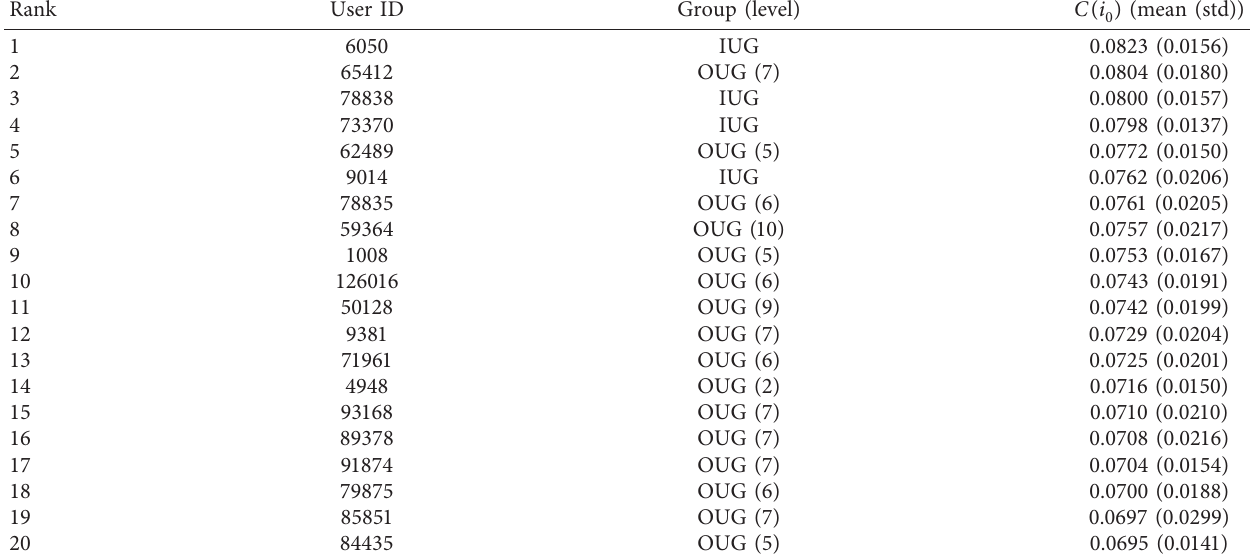
Table 4: Pollen Club Top 20 P10/P10 Plus users.